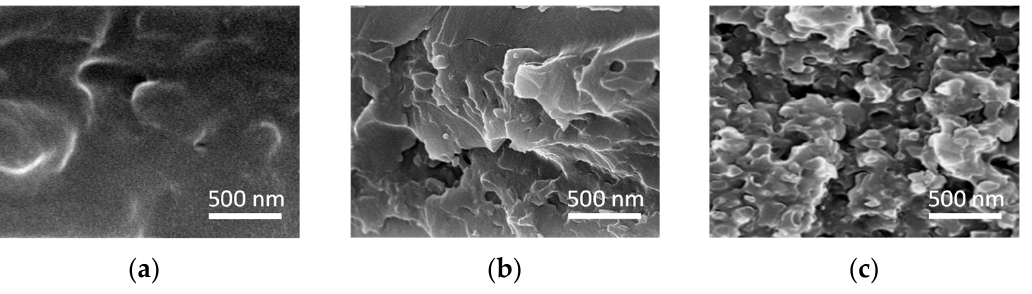
Figure 2. SEM top and cross section images of ( a ) the SU-8/PMMA membrane subjected to thermal and photoinduced hardening, ( b ) the SU-8/PMMA membrane after the PMMA photodegradation and ( c ) the SU-8 membrane after the PMMA removal.